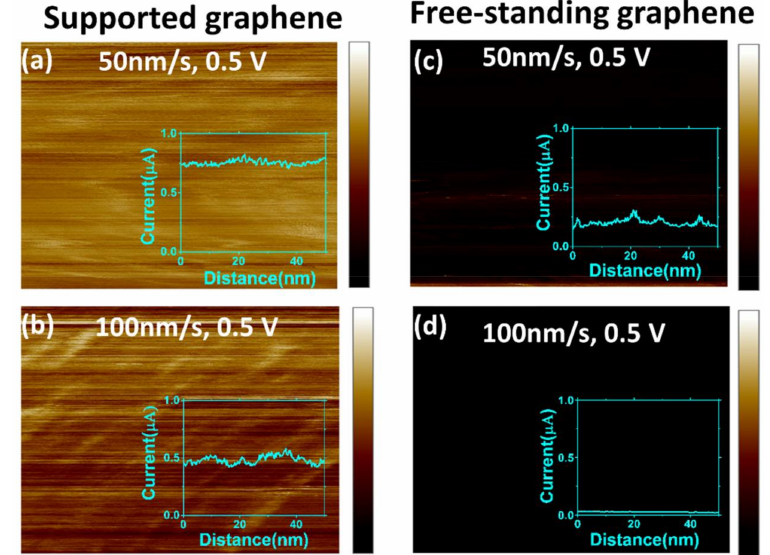
Figure 3. Conductive measurements during scanning of the graphene sample. Detailed 100 nm scans of the supported graphene area at scan speeds of ( a ) 50 nm/s and ( b ) 100 nm/s show that current was higher at the slower scan speed. In the case of free-standing graphene, overall conductivity is substantially lower both for ( c ) slow scanning and ( d ) faster scanning than for the supported graphene. In the case of the free-standing graphene, current is substantially reduced to ~0.2 µ A at a scanning velocity of 50 nm/s and to 0.01–0.02 µ A at 100 nm/s. The applied load was 5.4 nN for all results shown. The color scale bars cover the range from 0 up to 1.2 µ